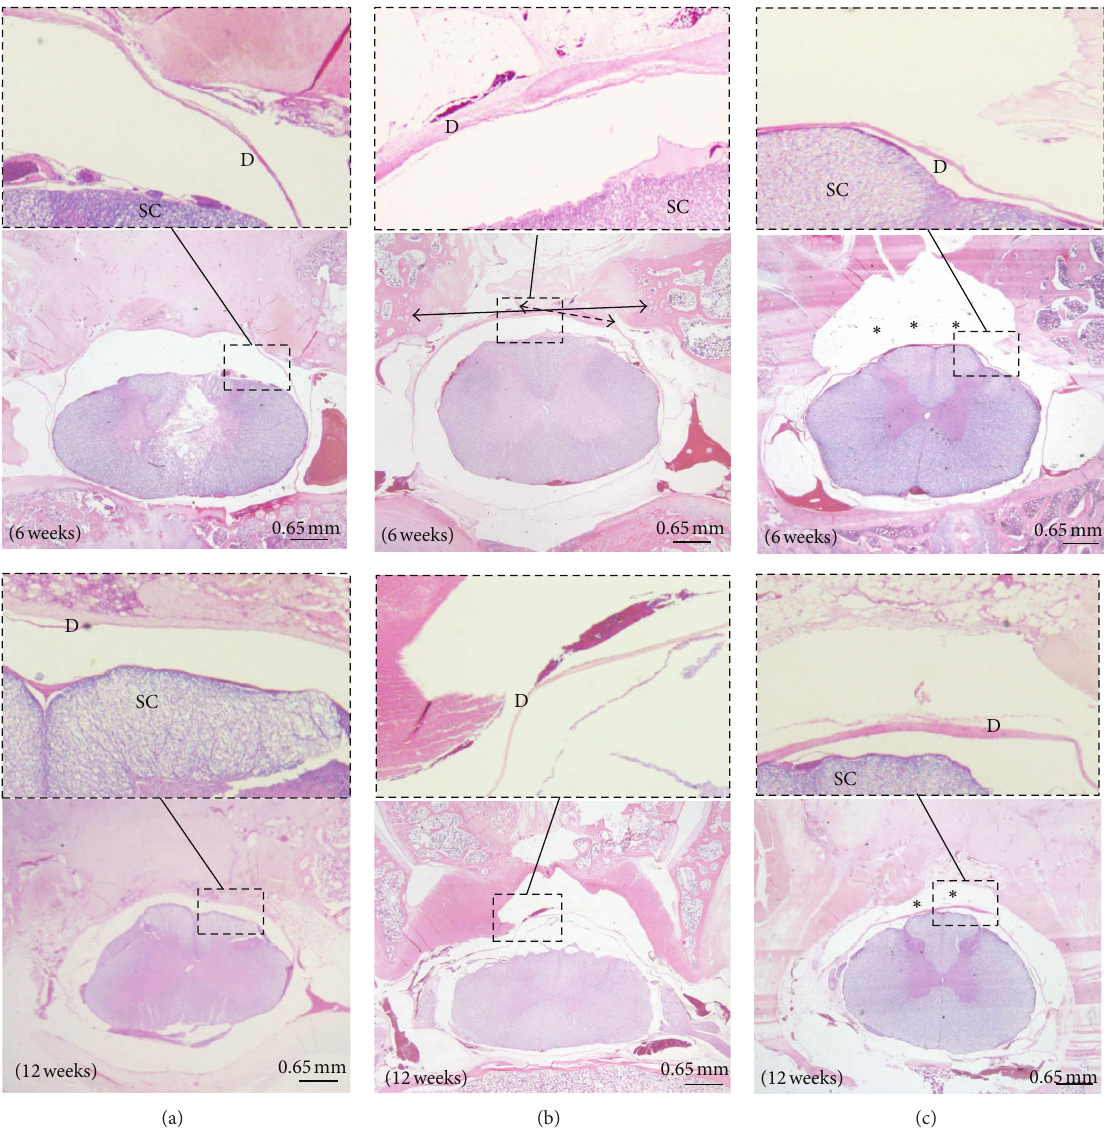
Figure 5: Histological sections (H&E staining, × 1.25) and magnified views ( × 40, dotted boxes) at weeks 6 and 12 after the operation ((a) control,groupI;(b)HA-CMC,groupII;(c)P-ALMC,groupIII).GroupIatboth6and12weeksshowedentirescartissueadhesiontotheentire exposed dura (D), graded 4. Group II showed a nondistorted dural contour, but the extent of adhesion (adhesion (dotted line)/laminotomy defect (solid line)) was graded 2 at week 6 and graded 0 at week 12. Group III showed a maintained clear area (asterisks) from the dura to the scar tissue at weeks 6 and 12, graded